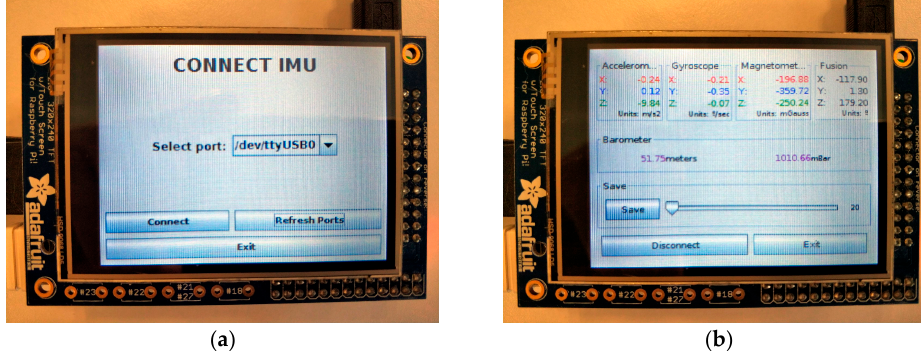
Figure 1. Main screens of the application: ( a ) IMU selection and connection; ( b ) Inertial sensor data visualization and data storage parameters.